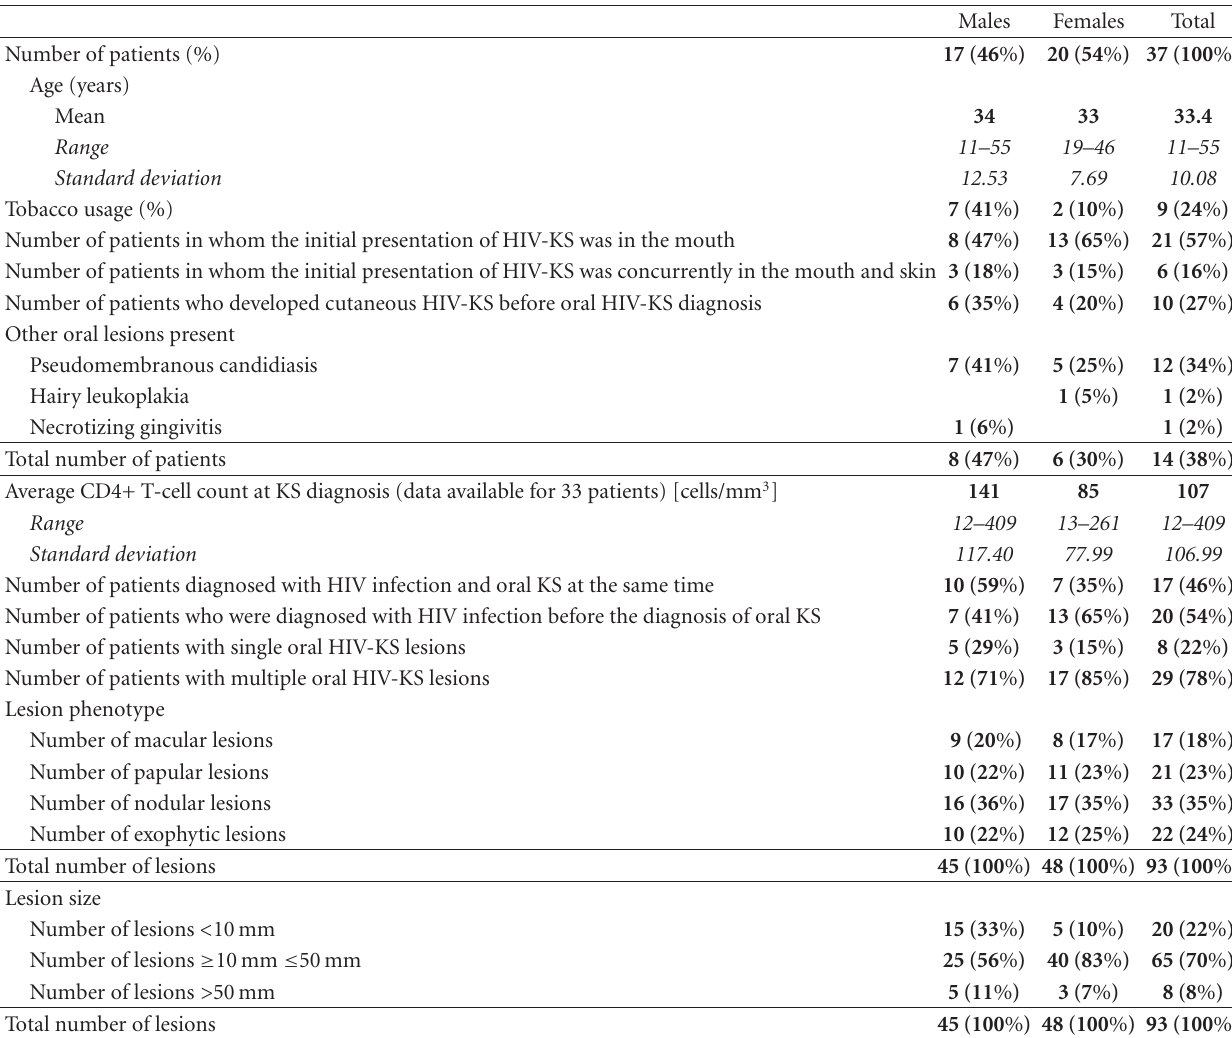
Table 1: Clinical and laboratory features of the patients at the time of oral HIV-KS diagnosis.